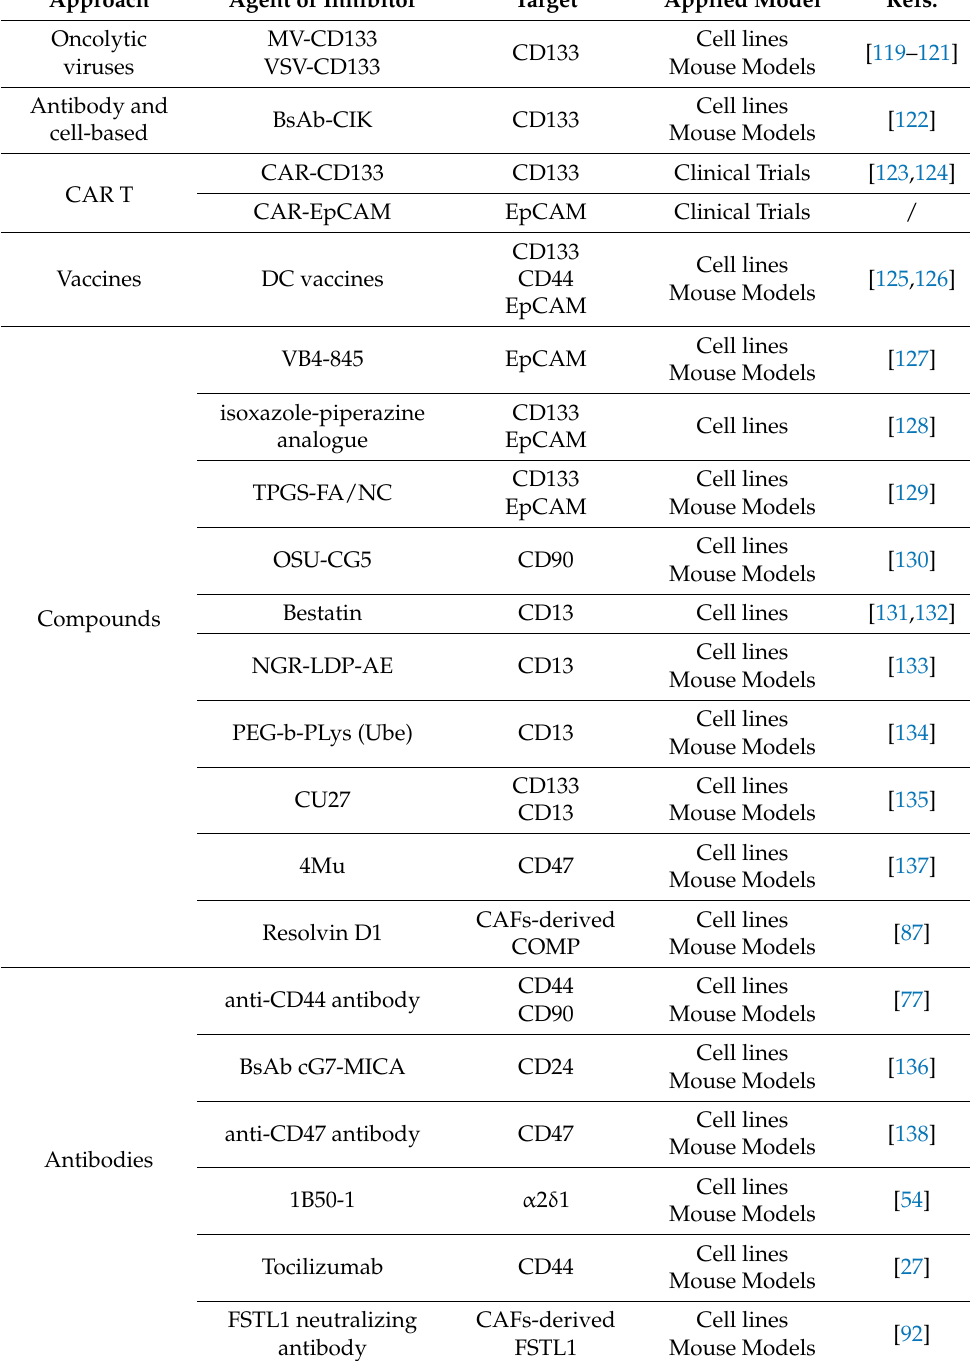
Table 2. The multiple hepatic CSCs-targeted therapeutic